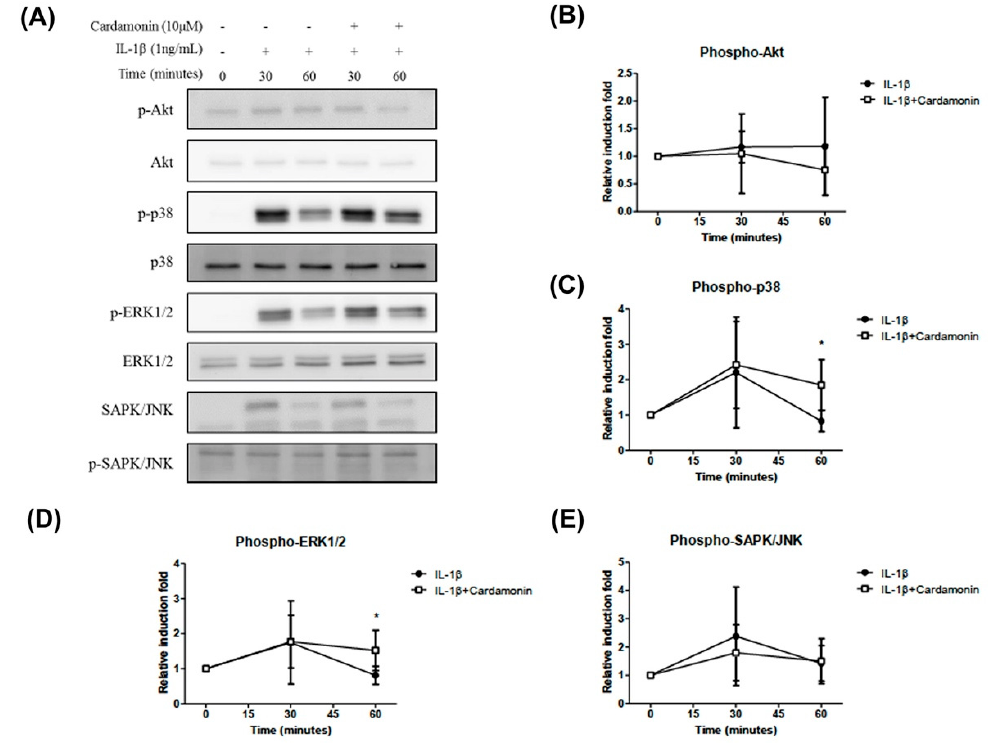
Figure 7. Effects of cardamonin on the activation of the p38/ERK signaling pathway in IL-1 β -induced human OA chondrocytes. ( A ) Representative Western blot analysis illustrating the effects of pretreating chondrocytes with cardamonin at a concentration of 10 µM for 0, 30 and 60 min prior to stimulation with IL-1 β . (Effects of treatment with 10 µM cardamonin